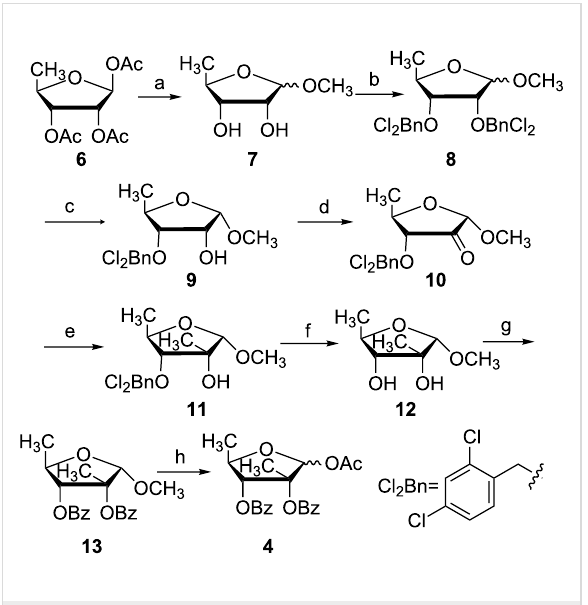
H-1, H-3, 5-CH 3 and 2- β -methyl. Then, the remaining 3-( O